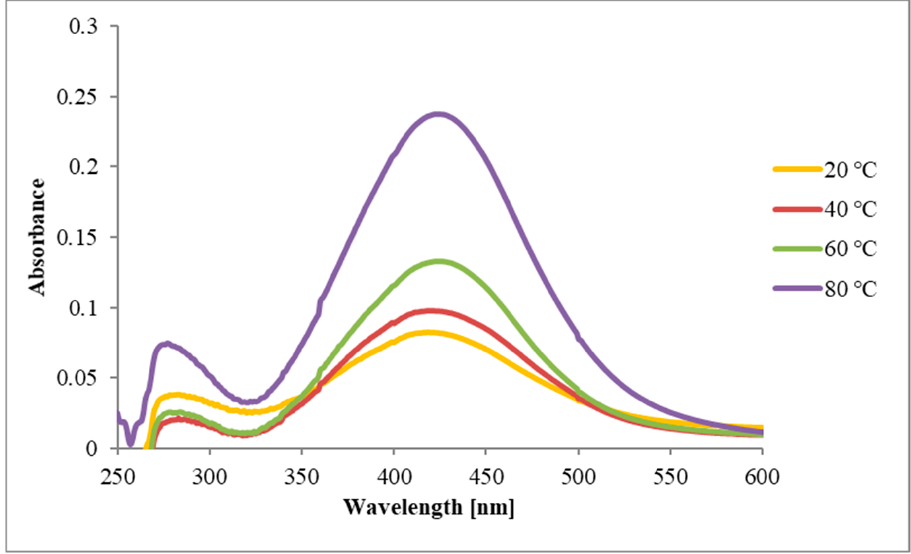
Figure 8. The influence of temperature (20 ◦ C, 40 ◦ C, 60 ◦ C, and 80 ◦ C) on AgNPs-EtOH formation.